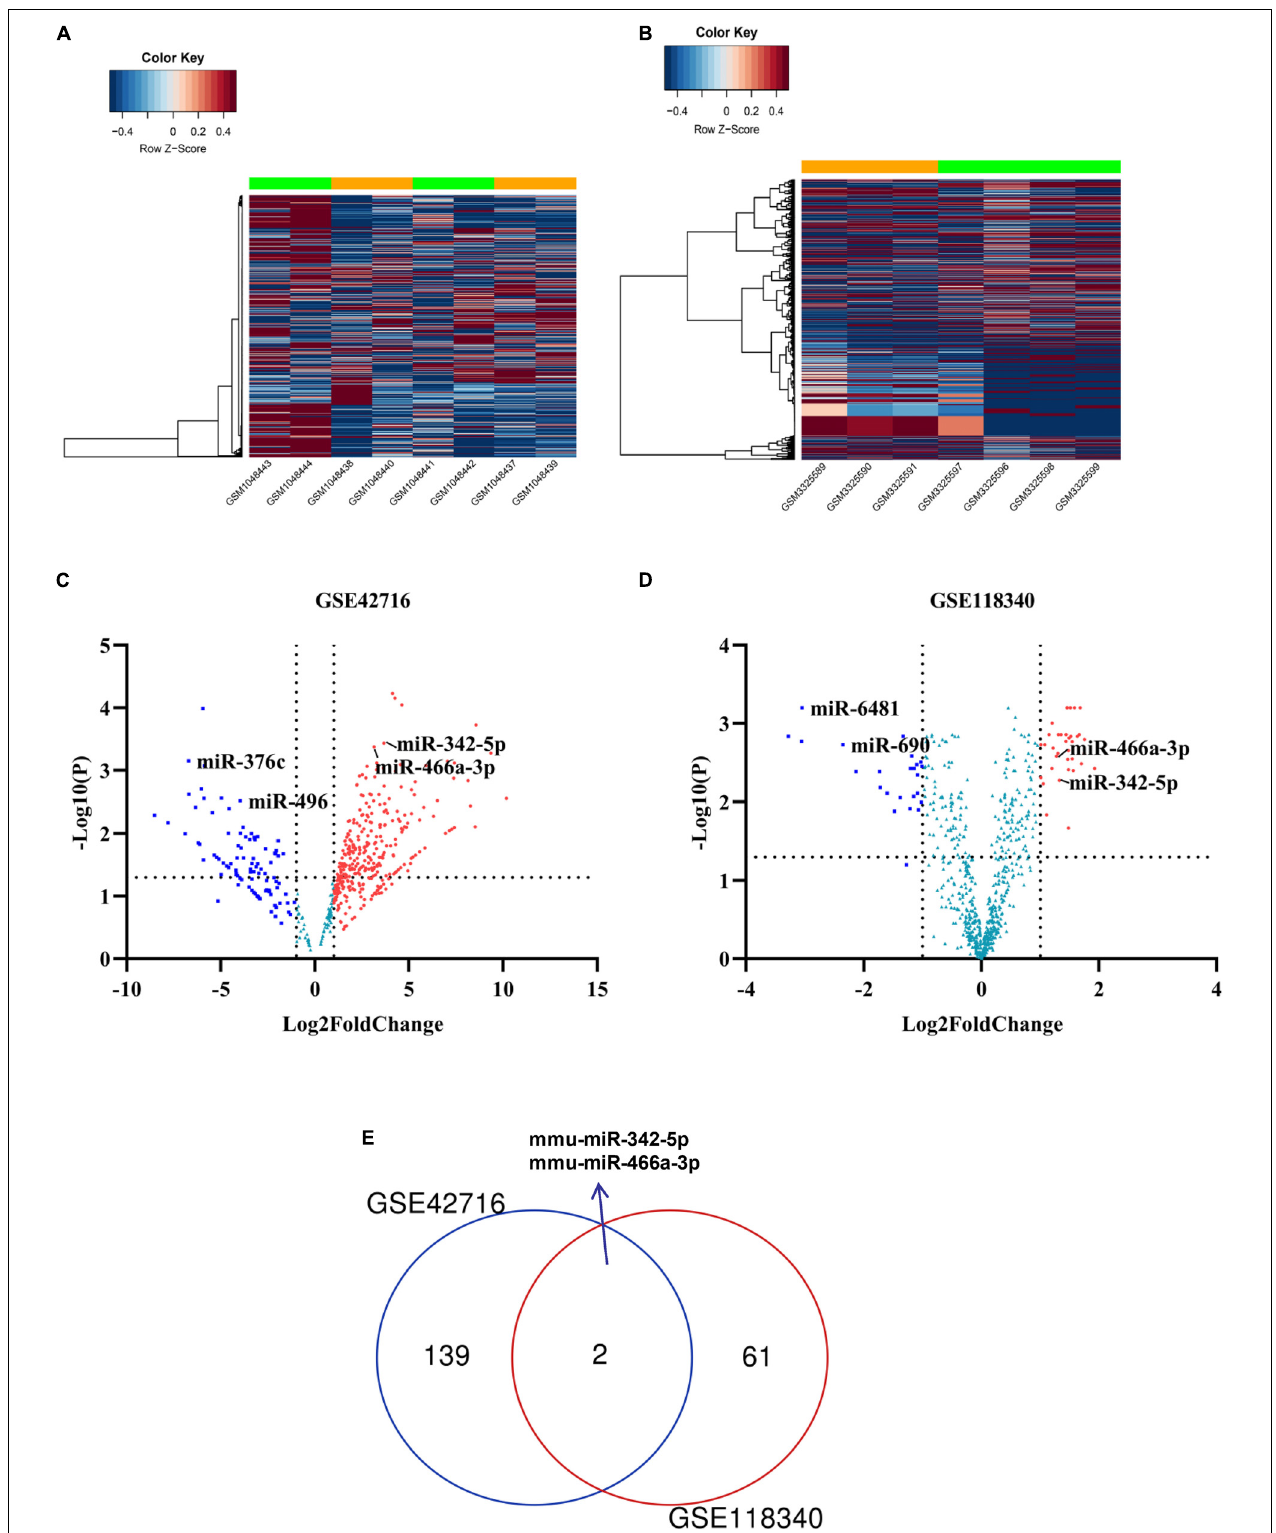
FIGURE 2 | Candidate DE-miRNAs were obtained from GSE118340 and GSE42718. (A,B) Heatmap showing the expression levels of each gene in different groups from GSE118340 and GSE42718. (C,D) Volcano plot showing the DE-miRNAs in GSE118340 and GSE42718. (E) Venn diagram showing miR-342-5p and miR-466a-3p are common DE-miRNAs in both GSE118340 and GSE42718.